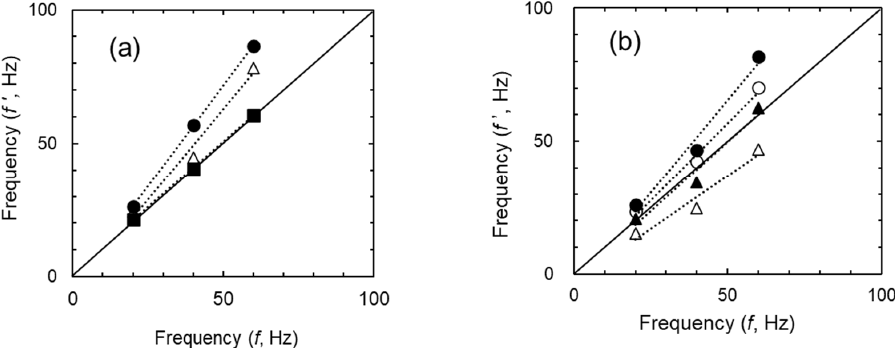
Figure 4. Slug lengths of ( a ) aqueous phase and ( b ) oil phase under various volumetric flow rates and frequencies. Solid line: computed using Equation (1); dashed line: computed based on the effective frequency shown in Figures 5 and 6.